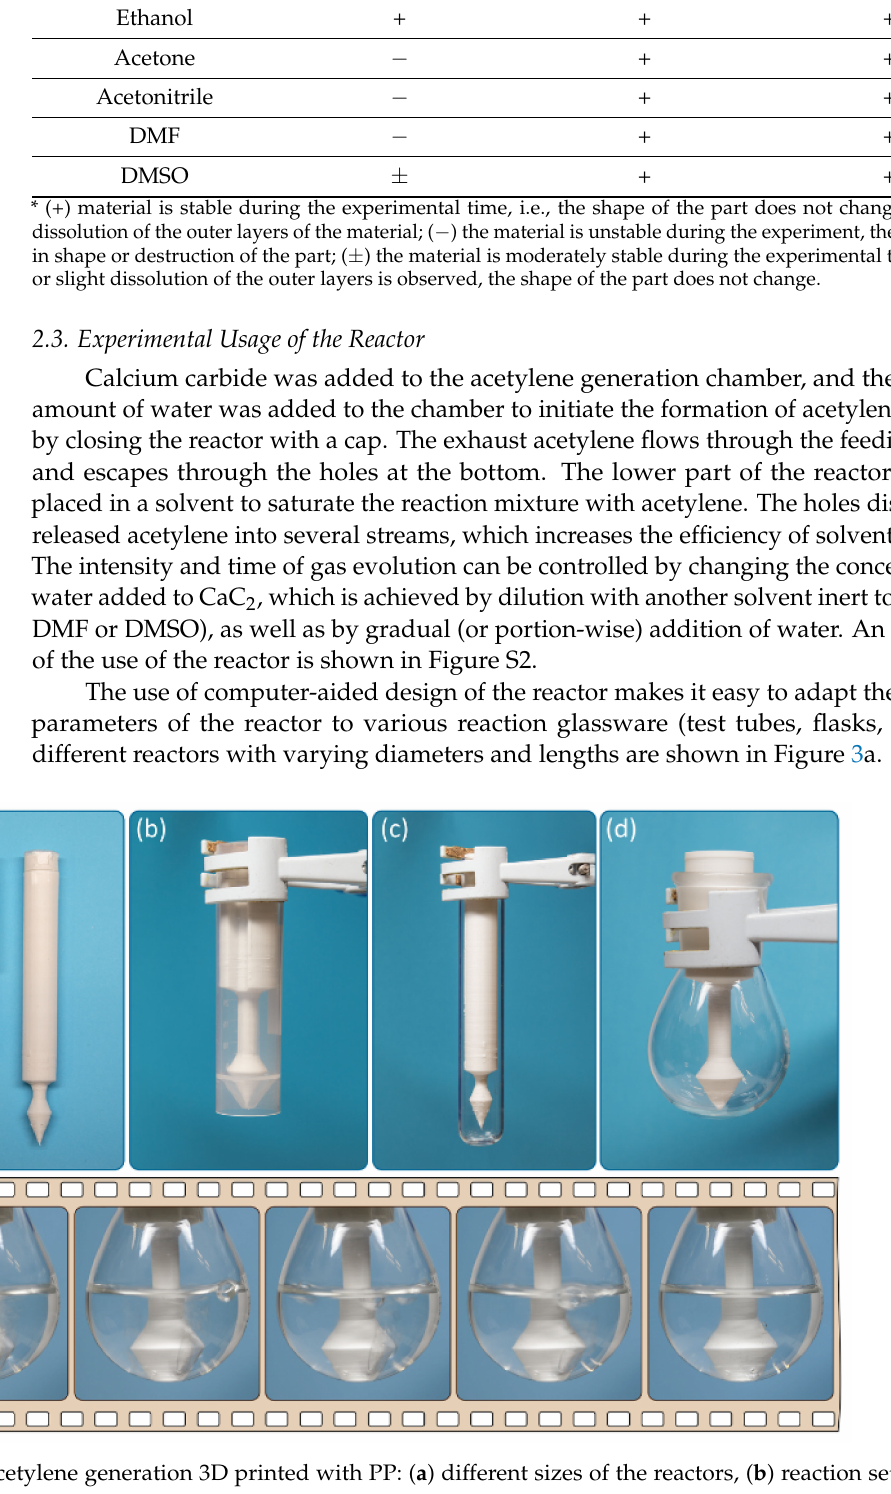
Figure 3. Reactors for acetylene generation 3D printed with PP: ( a ) different sizes of the reactors, ( b ) reaction setup for synthesis of 1,4-bis(arylthio)buta-1,3-dienes, ( c ) reaction setup for synthesis of 1,2-bis(arylthio)ethenes, ( d ) reaction setup for synthesis of vinyl derivatives, and ( e ) snapshots of acetylene